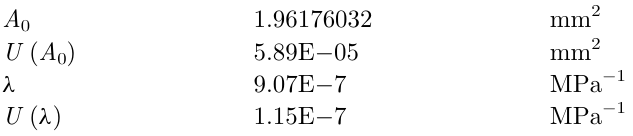
Table 3. Results of sensor cross fl oating calibration. Table 2. Results of the direct cross fl oating